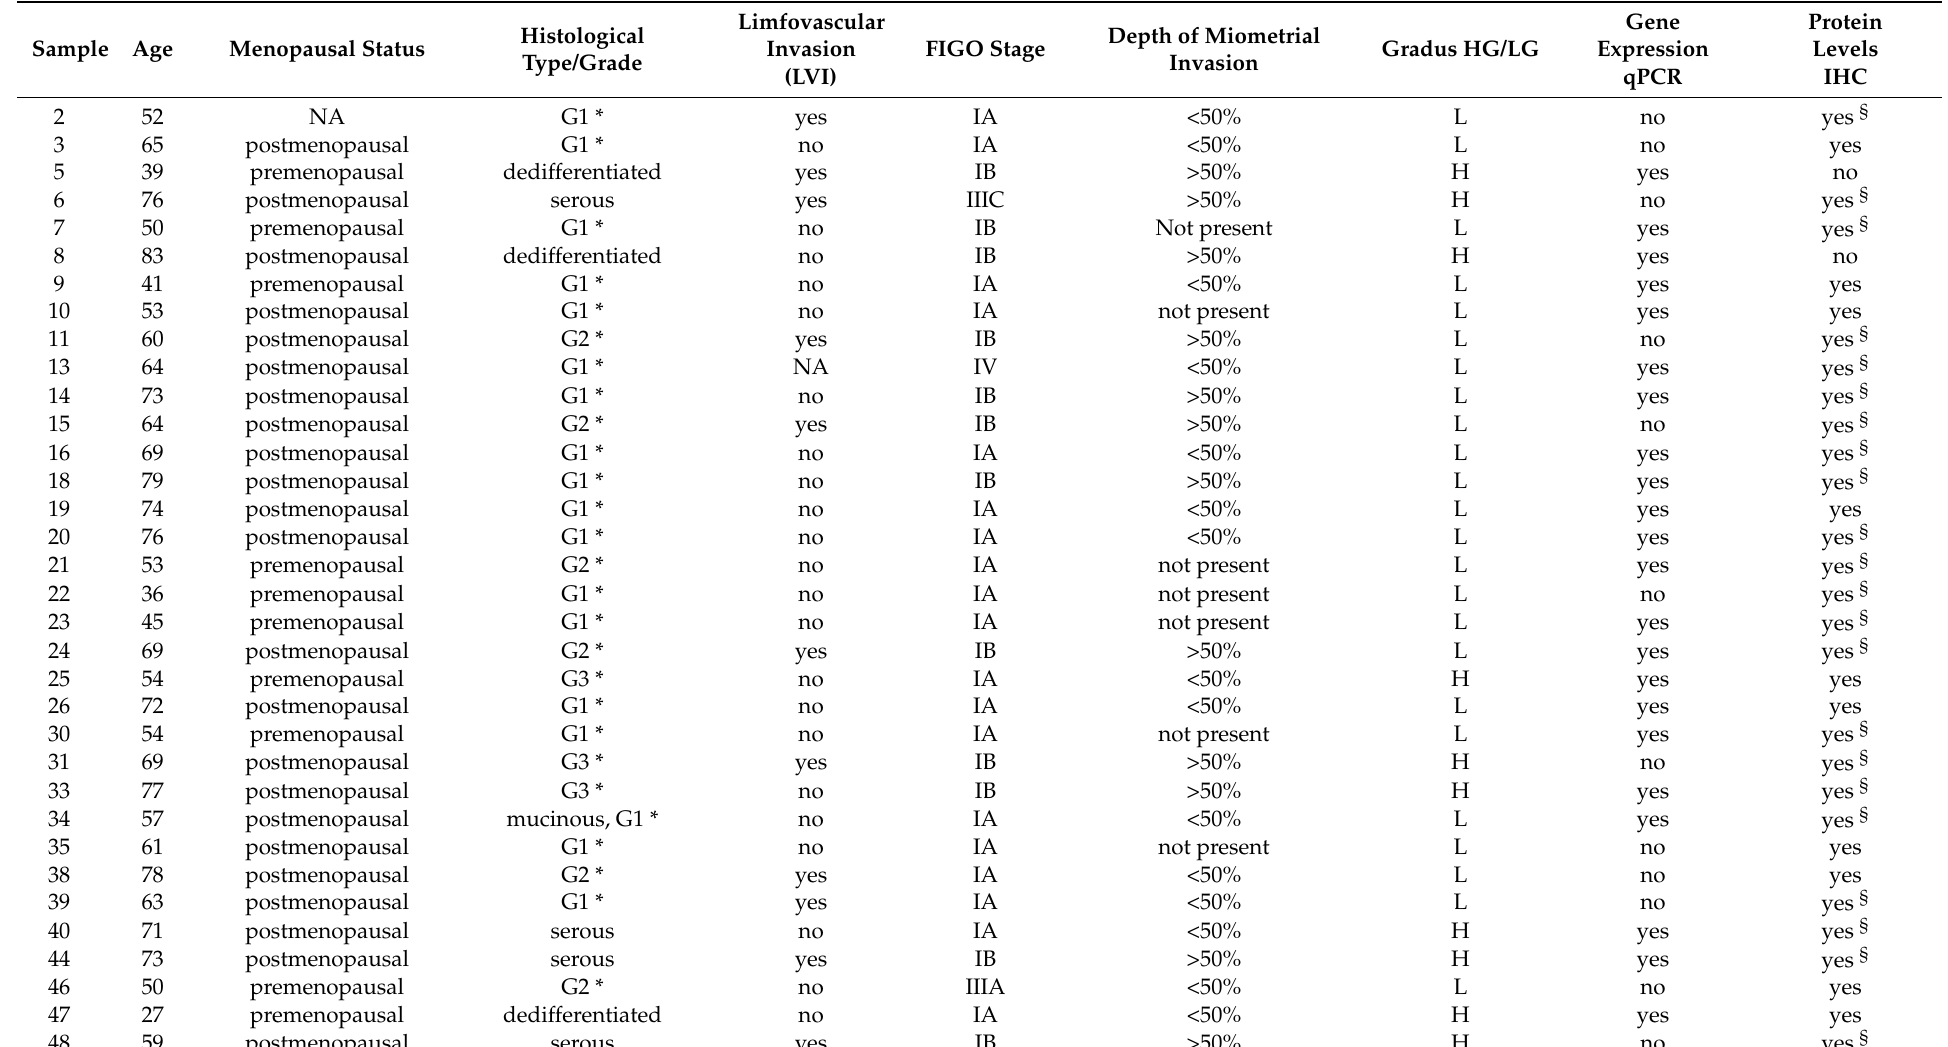
Table 3. Detailed information about patients included in this